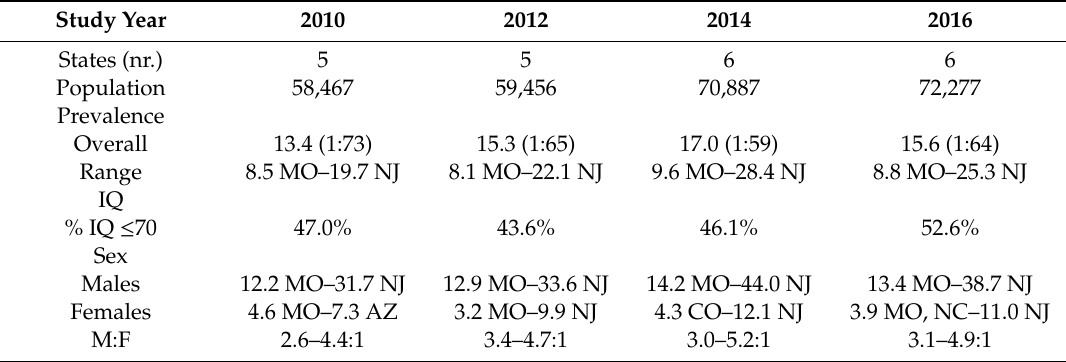
Table 6. CDC-ADDM Network ASD prevalence estimates per 1000 children aged 4 years, in the overall group and in sex and ethnicity subgroups, from 2000 to 2016 in USA